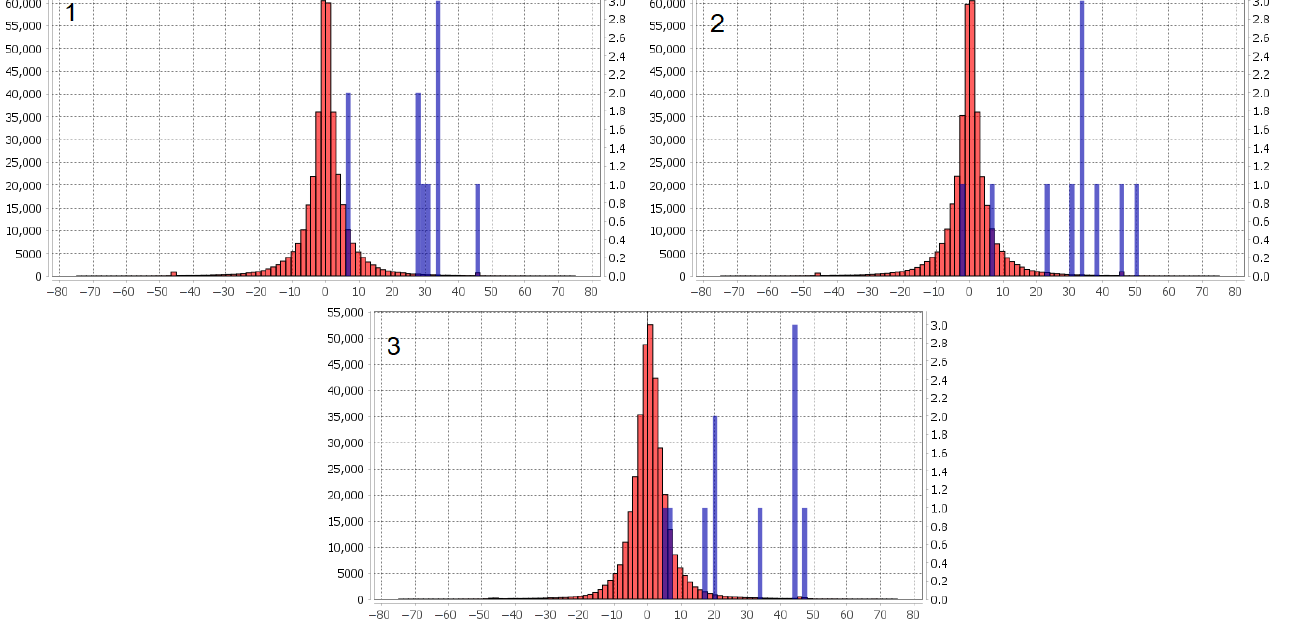
Figure 7. Histograms of the values of divergence field F 4 ( 1 ), rotor field F 5 ( 2 ), and shear field F 6 ( 3 ), as well as histograms of earthquake precursors, during the testing interval from 2 February 2016 to 26 January 2023 in Japan region. The red bars represent the distribution of field values, while the blue bars show the distribution of earthquake precursor